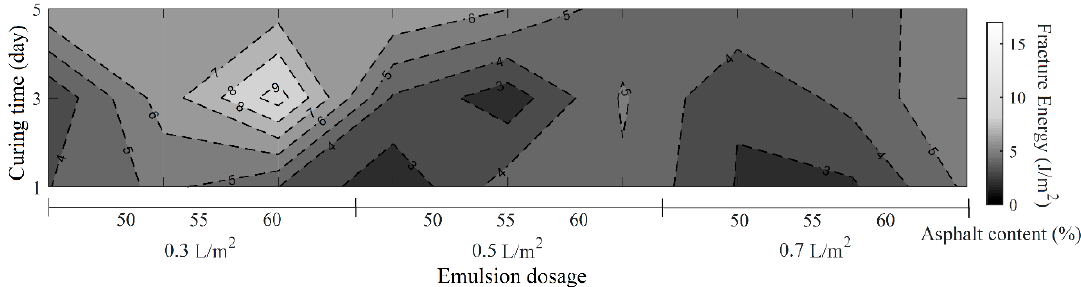
Figure 7. Fracture energy diagram of the rapid setting asphalt emulsions for different dosages and cure times.